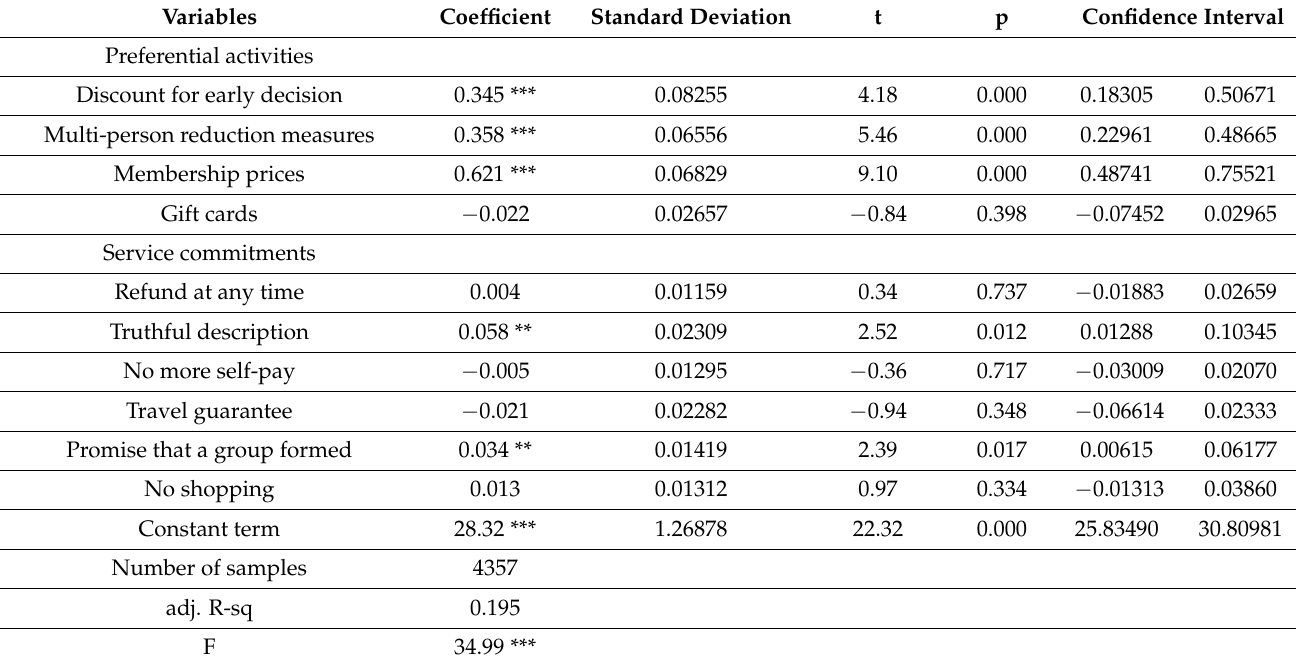
Table 3. The results of regression: the impact of expected product characteristics of online itineraries on purchasing behavior. Variables